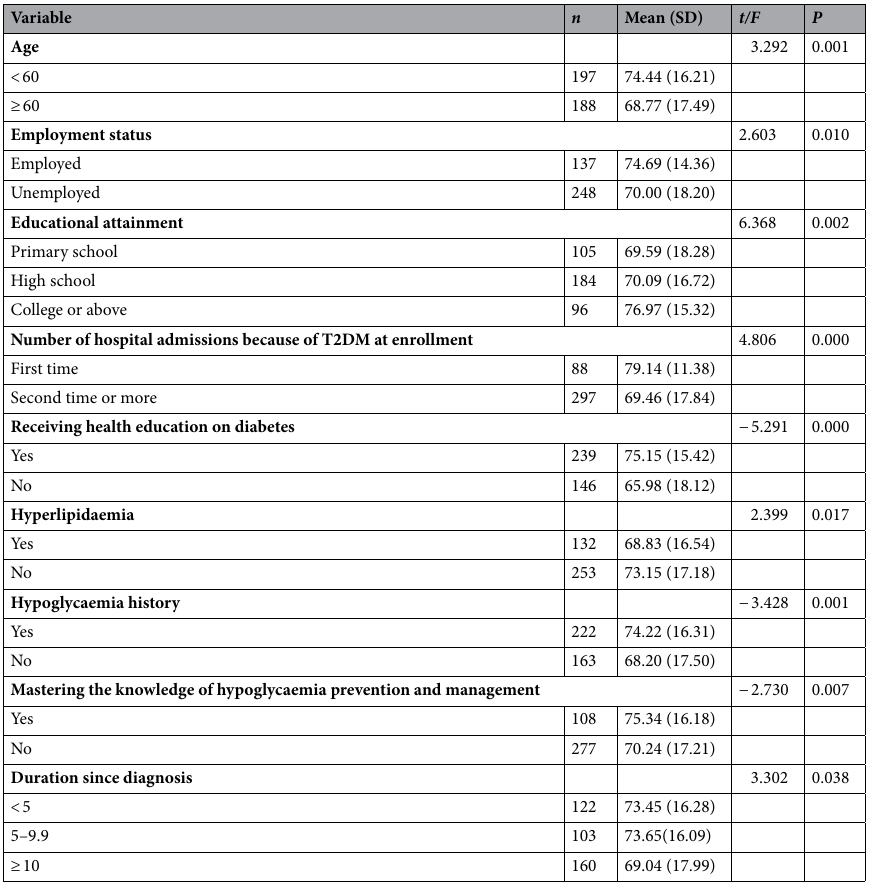
Table 4. Differences in fear of hypoglycaemia among various sociodemographic and clinical subgroups ( n = 385). SD, standard deviation; T2DM, type 2 diabetes mellitus.